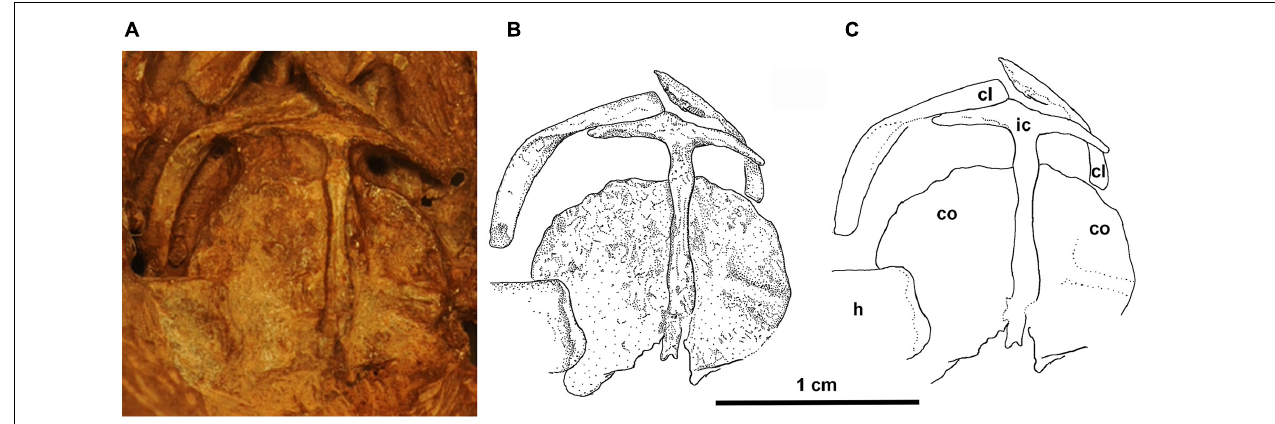
FIGURE 5 | Eudibamus cursoris , holotype (MNG 8852). (A) Photograph, (B) illustration, and (C) outlines of individual elements of shoulder girdle in ventral view.